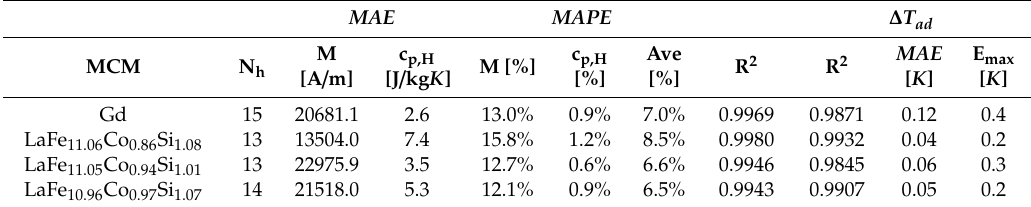
Table 2. Summary of the results carried out by implementing the ANN-based procedure with Gd and the three samples of La-Fe-Co-Si alloy. MAE MAPE ∆ T